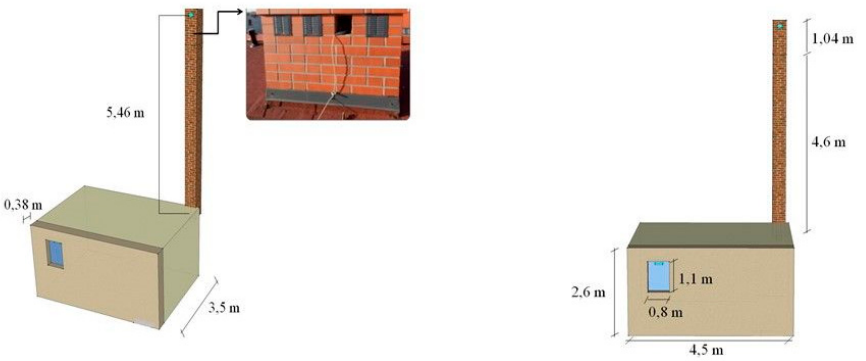
Figure 4. Test room and stack ventilation system, TYPE I.